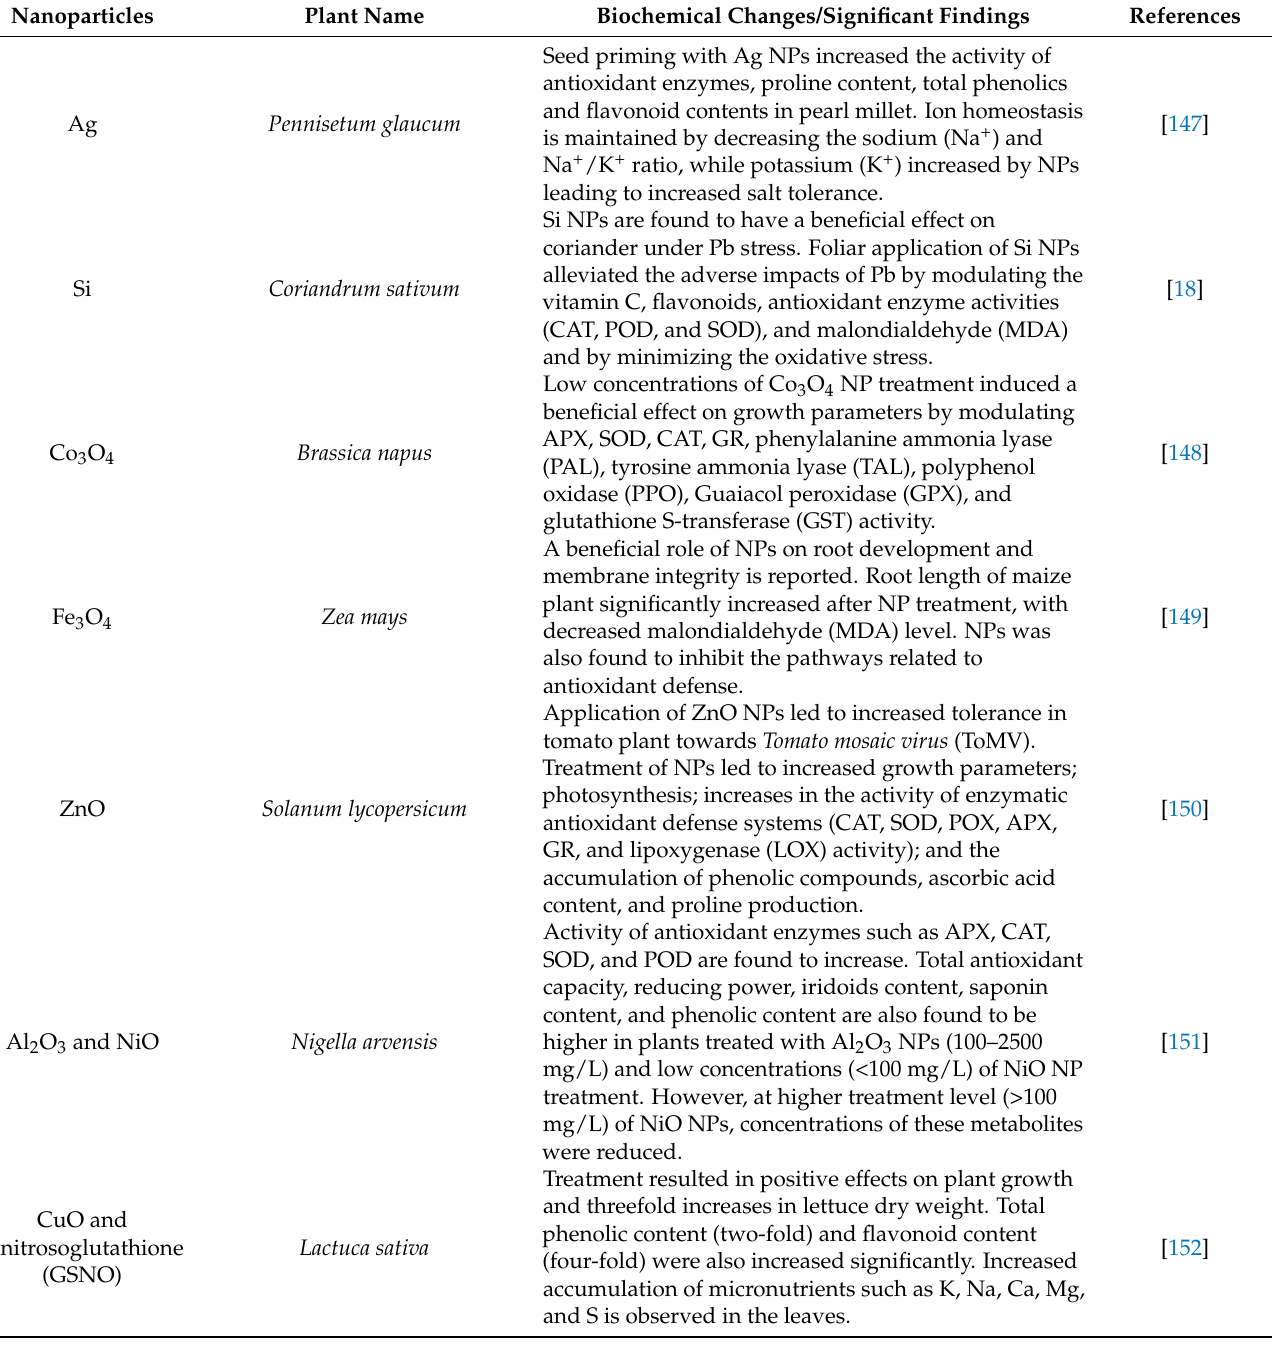
Table 4. Some recent studies on the use of nanoparticles influencing the antioxidant defense system of the plant.